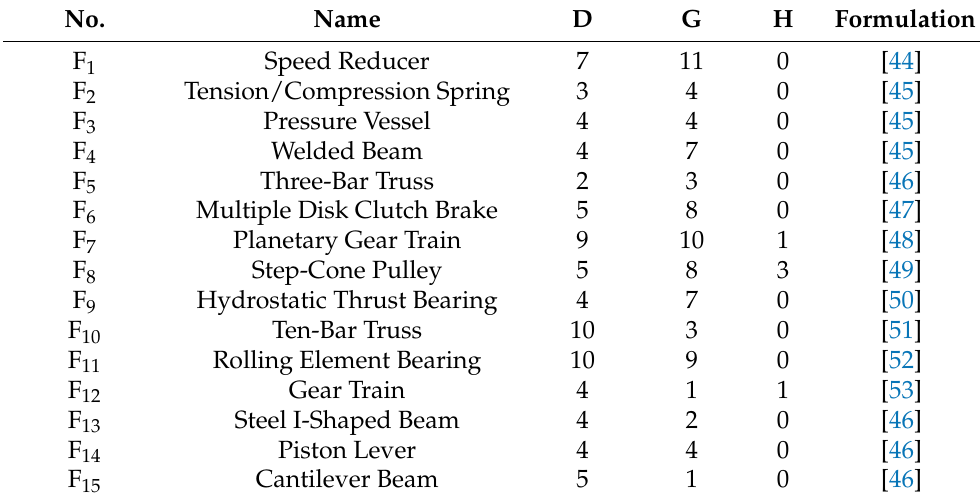
Table 3. Description of the constrained engineering design